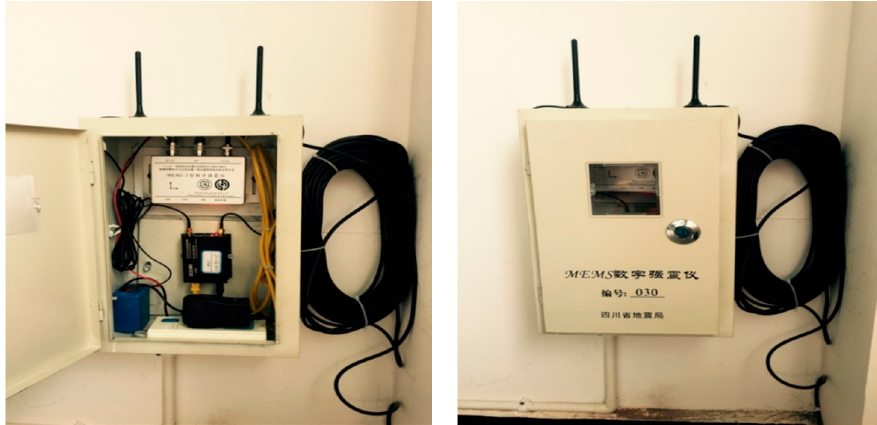
Figure 13. The installation of the seismic sensor in a village hall in Sichuan.